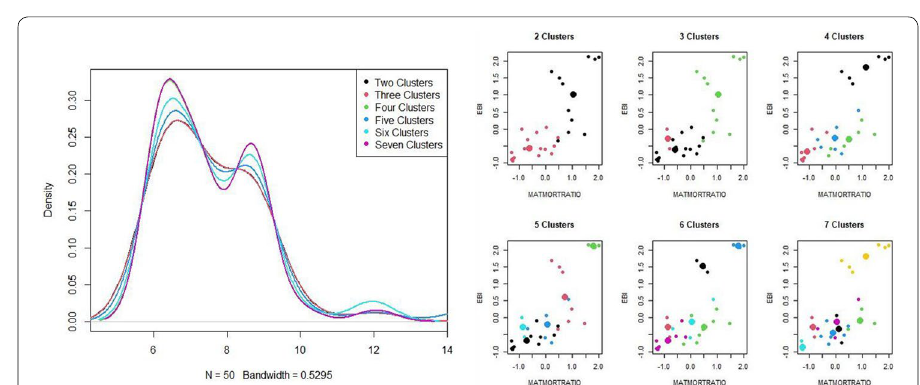
Fig. 6 Within and between cluster variations for the clusters on the RHS based on 30 sample